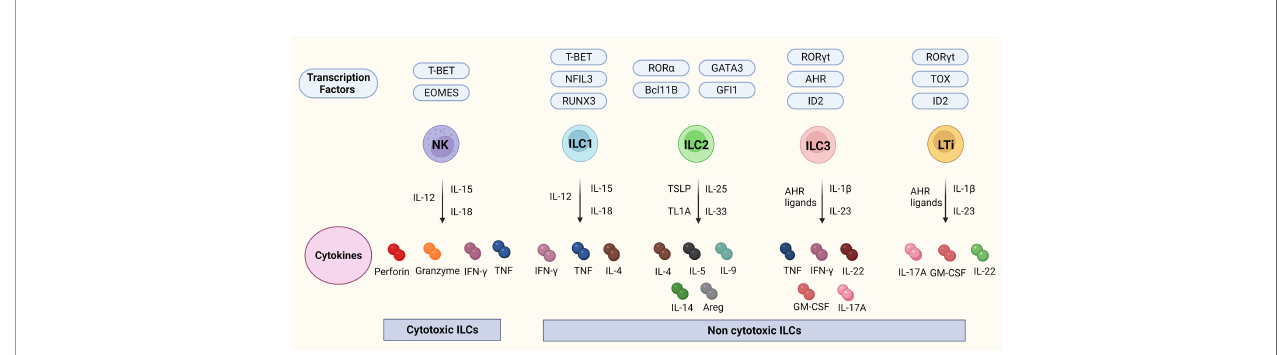
FIGURE 1 | ILCs, their transcription factors, and cytokines. Figure 1 depicts the ILC family, their transcription factors, and cytokines in mice. NK cells are transcription factor T-bet and Eomes dependent cytotoxic ILCs that release cytokines IFN- g , and TNF together with cytotoxic molecules such as perforin, and granzyme. ILC1-3 and LTis are non-cytotoxic ILCs. ILC1s are dependent on the transcription factors Tbet, NFIL3, and RUNX2 and release IFN- g , TNF, and IL-4. ILC2s are dependent on the transcription factors ROR a , GATA3, Bcl11B, and GFI and release IL-4, IL-5, IL-9, IL-14, and transcription factor Areg. ILC3s are dependent on the transcription factors ROR g t, AHR, and ID2 and release TNF, IFN- g , IL-22, GM-CSF, and IL-17A. LTis are dependent on the transcription factors ROR g t, TOX, and ID2 and release IL-17A, GM-CSF, and IL-22. Abbreviations of transcription factors: NFIL3, nuclear factor IL-3 induced; ID2, inhibitor of DNA binding 2; TOX, thymocyte selection associated high mobility group box protein; GATA3, GATA binding protein 3; T-BET, T-box transcription factor; EOMES, Eomesodermin; RUNX3, runt-related transcription factor 3; ROR a , RAR-related orphan recepto;, Bcl11b, B cell lymphoma/leukemia 11B; ROR g t, RAR- related orphan receptor g t; and AhR, Aryl hydrocarbon receptor. Abbreviations of cytokines: IFN- g , Interferon-gamma; TNF, Tumor necrosis factor-alpha; IL, Interleukin; GM-CSF, Granulocyte-macrophage colony-stimulating-factor; Areg,